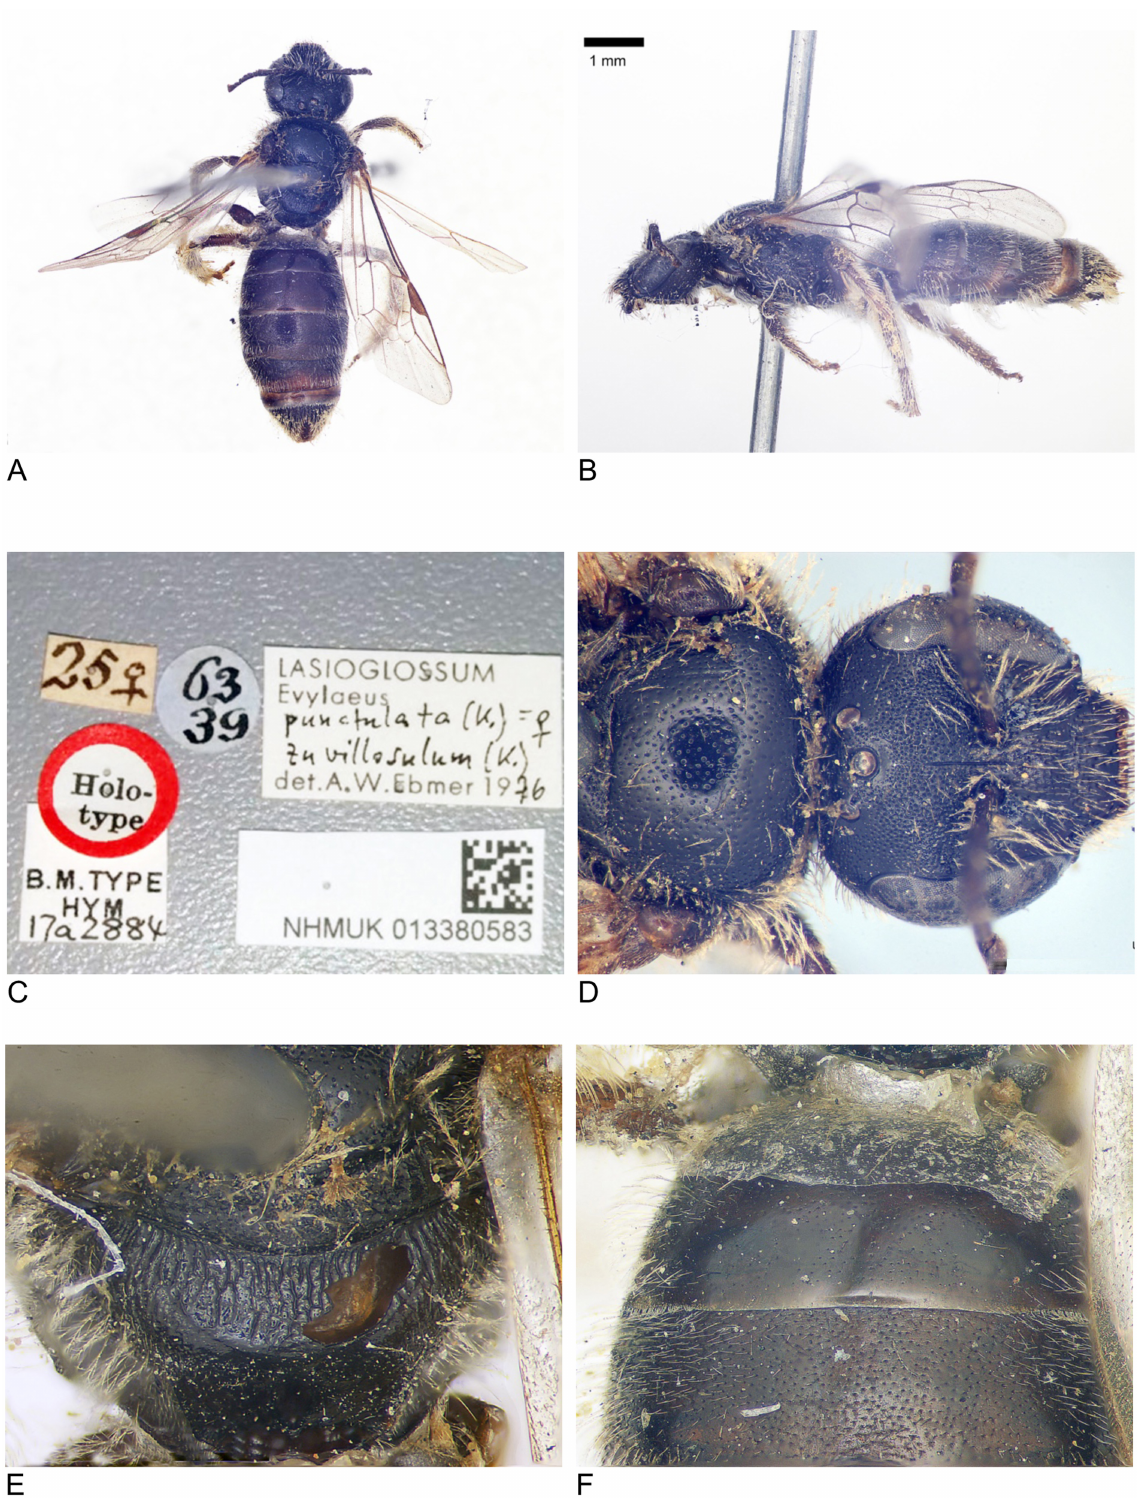
Fig. 7. Melitta punctulata Kirby, 1802, holotype, ♀. A . Habitus, dorsal view. B . Habitus, lateral view. C . Labels. D . Scutum and head. E . Propodeum. F . Tergum 1 and 2 (metasoma